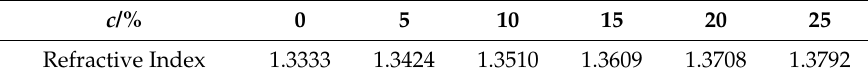
Table 1. NaCl Solution refractive index table along with the change of concentration.